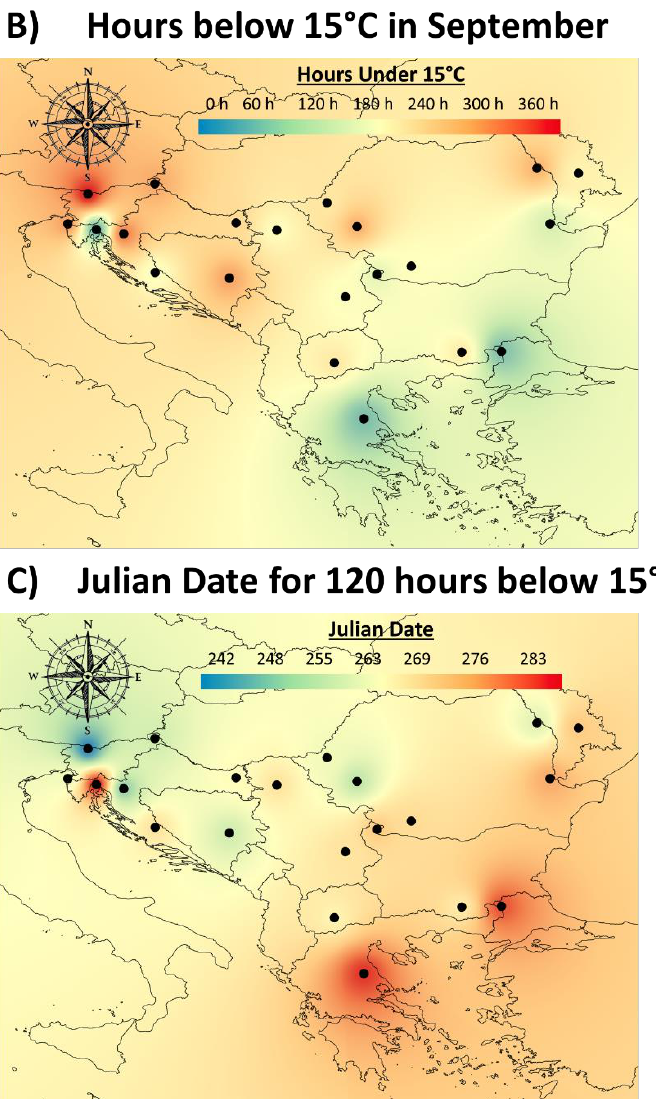
Figure 1. Spatial interpolation of hours below 15 °C in August ( A ) and September ( B ), as well as Julian date by which 120 h below this temperature are accumulated ( C ) based on 10-yr historical averages at selected weather stations in the Balkan region.